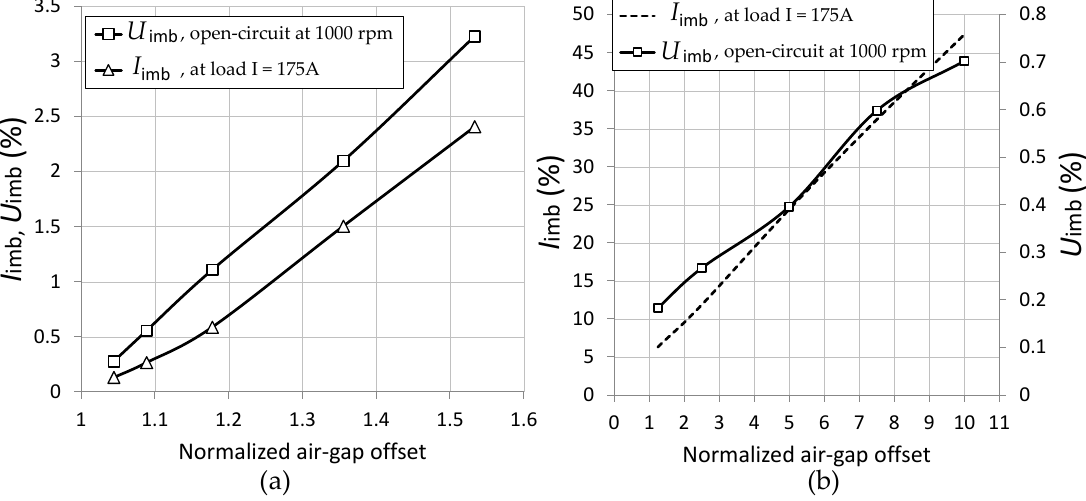
Figure 13. Imbalance amplitude of phase current and voltage at open-circuit for two different misalignment effects: ( a ) Normalized air-gap offset; ( b ) stator offset.